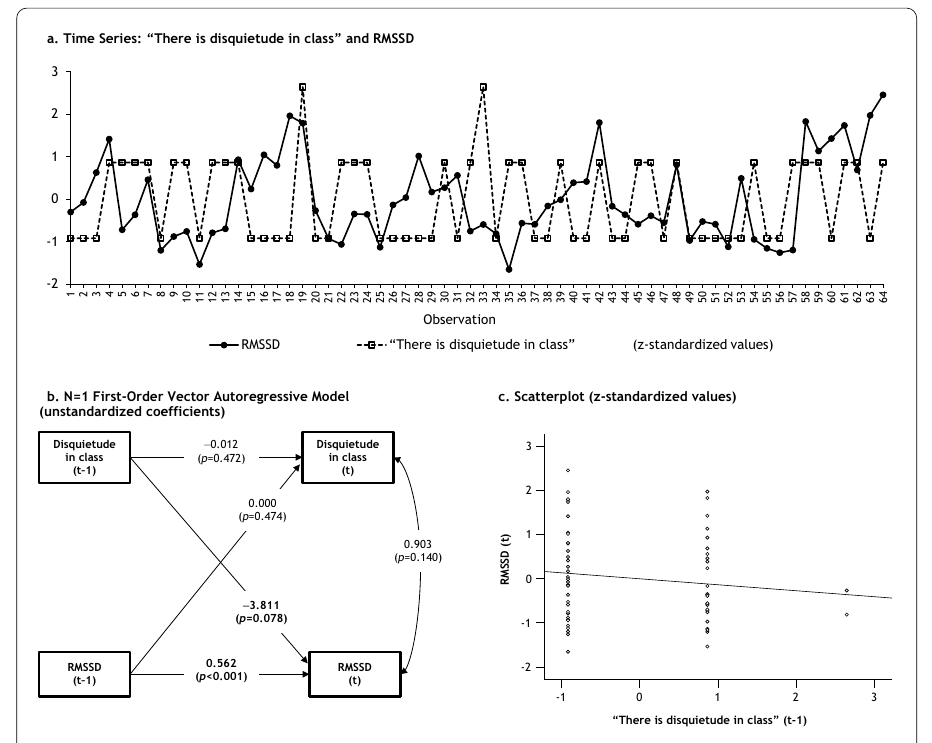
Fig. 3 “There is disquietude in class” and